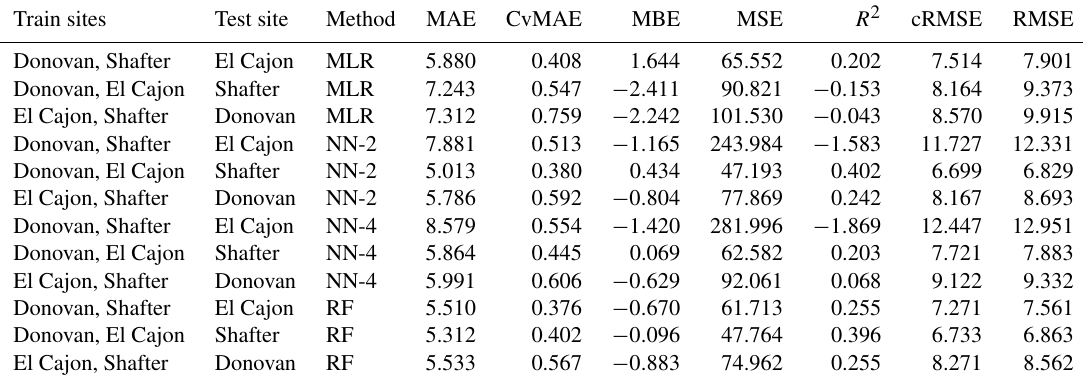
Table C10. Level 2 test results for NO 2 .